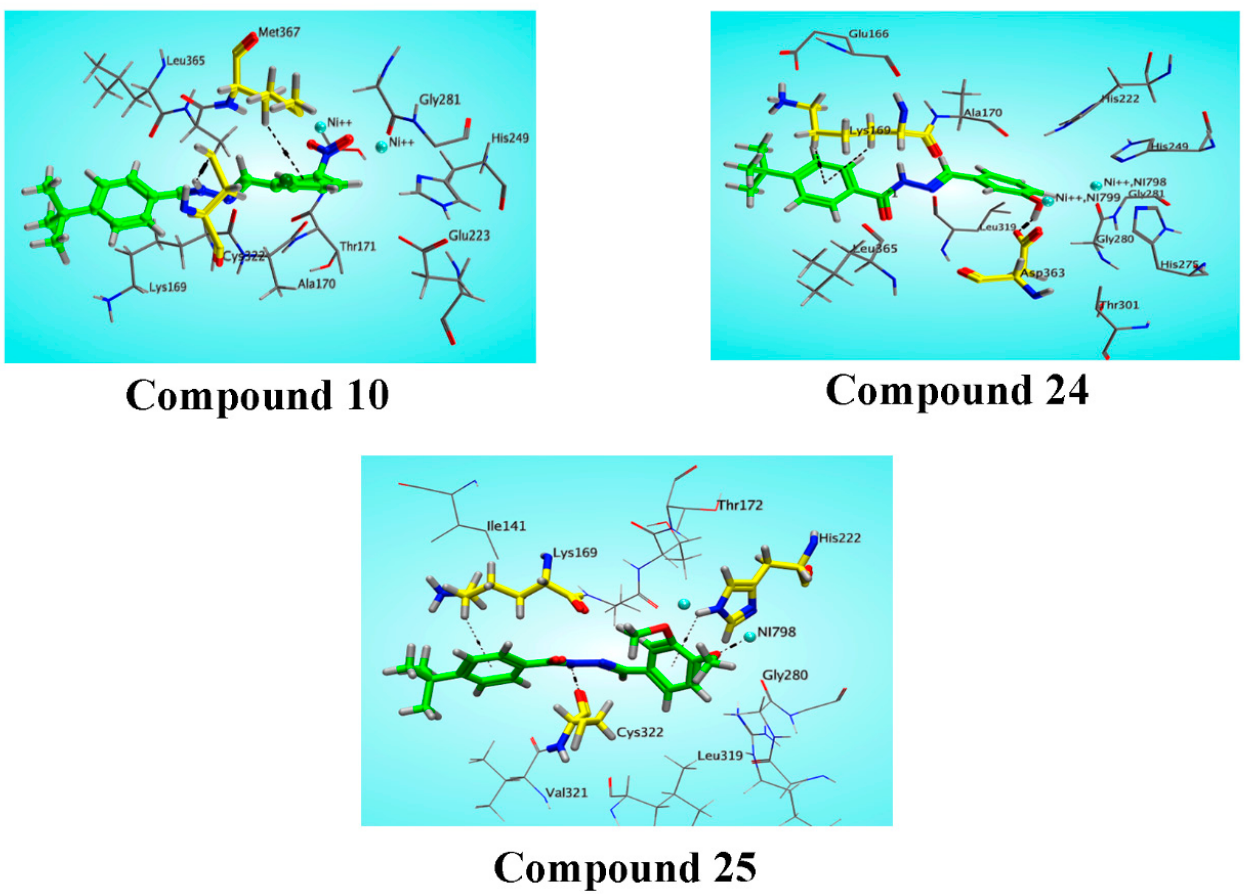
Figure 6. Three dimensional interaction of compounds 10 , 24 , 25 , with active site residues of urease. Ligands are shown in green, key residues of the active site are shown in yellow stick mode, hydrogen bonding and other interaction is shown in dark color dotted lines.